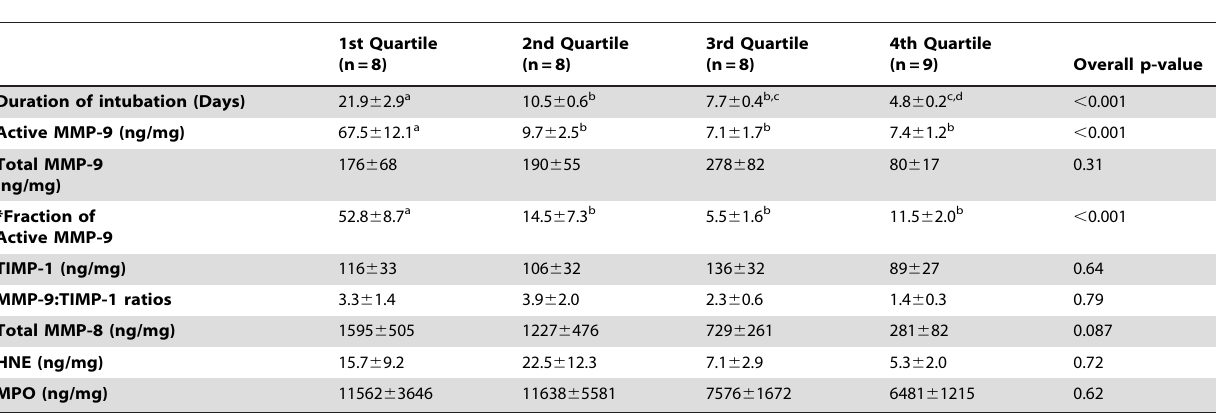
Table 3 . Examination of 48 hour inflammatory markers in ARDS subjects, segregated into quartiles for length of